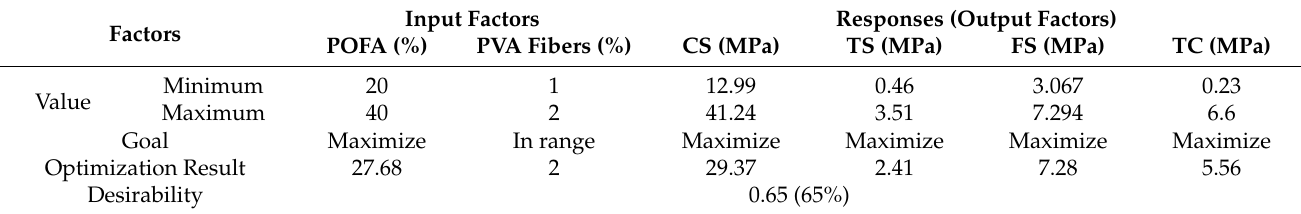
Table 7. Optimization criteria and